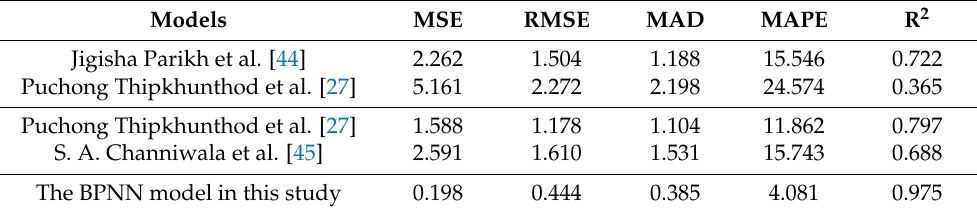
Table 5. Comparison of the models for predicting of HHV using all